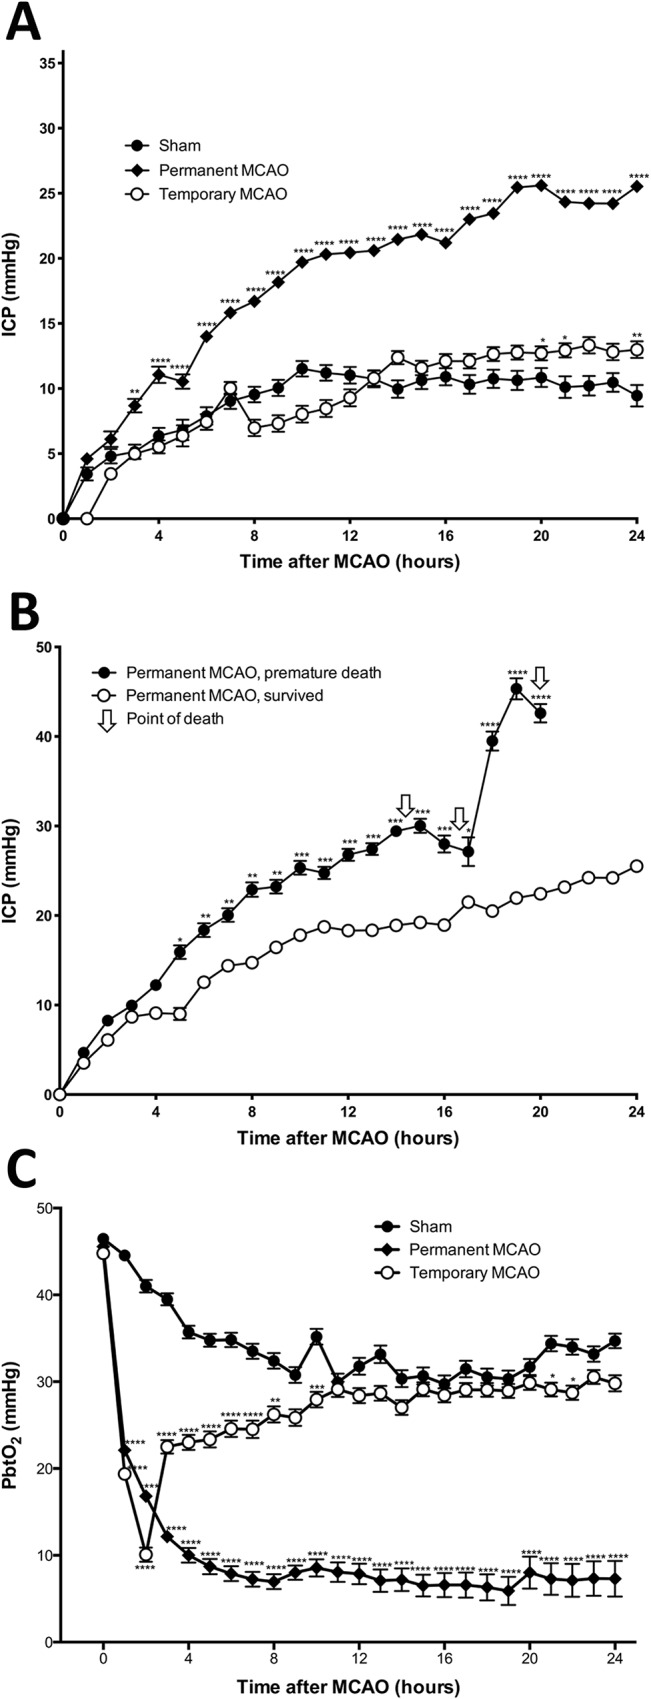
Mean 24 hour ICP and PbtO2 following MCAO.Mean ICP following sham surgery, temporary MCAO or permanent MCAO (A). Mean ICP following permanent MCAO, animals that died within the 24-hour monitoring period versus animals that survived (B). Mean PbtO2 following temporary and permanent MCAO or sham surgery (C). ICP, intracranial pressure; MCAO, middle cerebral artery occlusion; PbtO2, partial pressure of brain tissue oxygen, n = 8–12/gp.